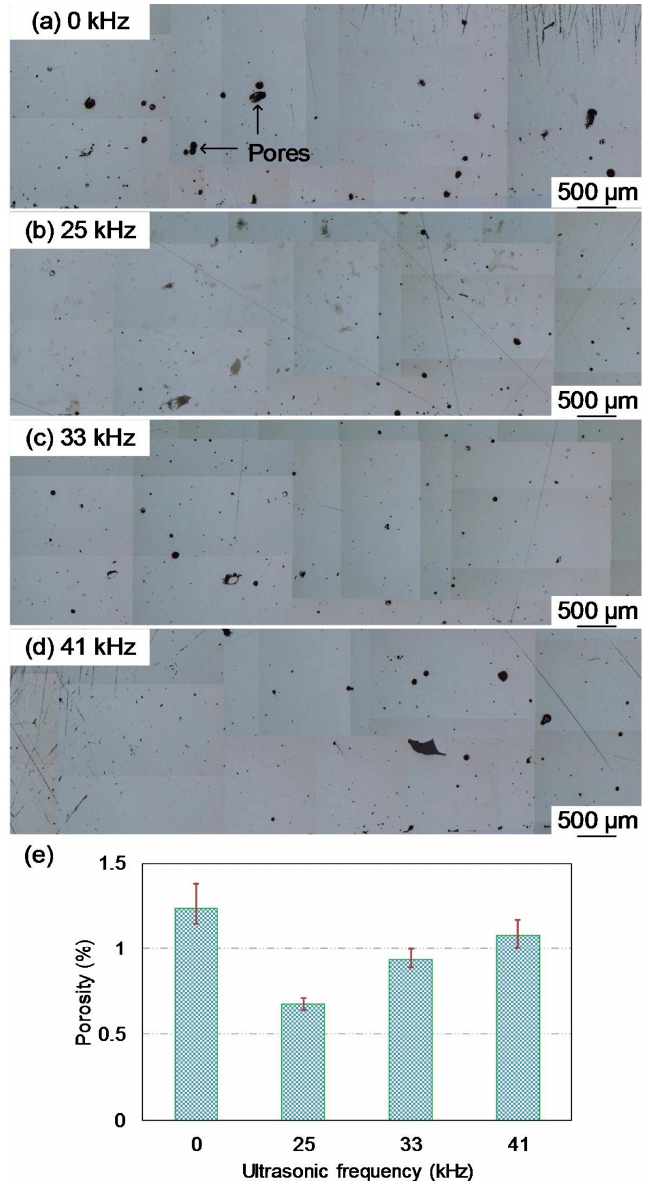
Figure 6. Effects of ultrasonic frequency on porosity: ( a ) 0; ( b ) 25; ( c ) 33; ( d ) 41 kHz; (e) effects of ultrasonic frequency, reproduced or adapted from [43], with permission from Elsevier, 2020.